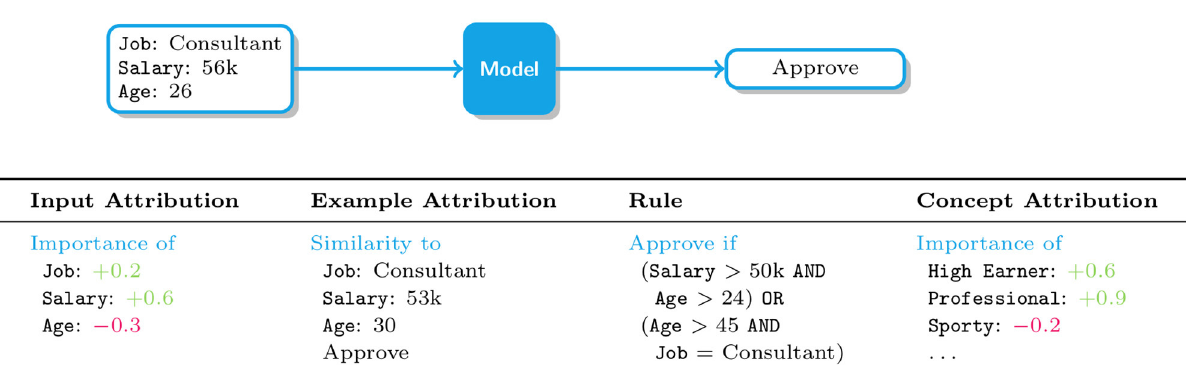
end, it presents users with explanations that illustrate the